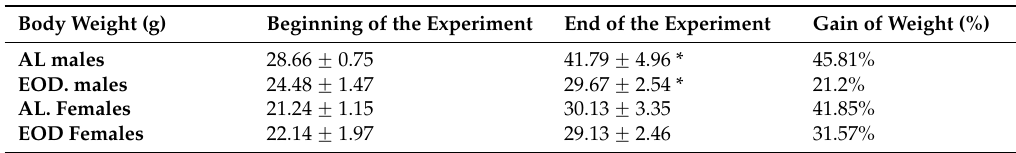
Table 2. Body weight of animals on every-other-day (EOD) diet and ad libitum (AL) fed during 9 months of treatment.